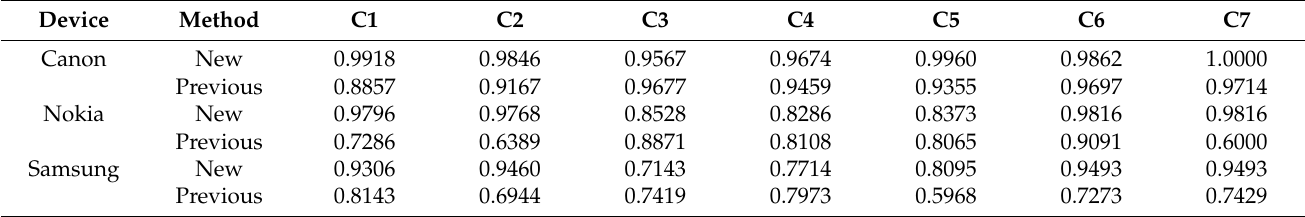
Table 7. Performance comparison between our new method and the best results obtained by previous methods